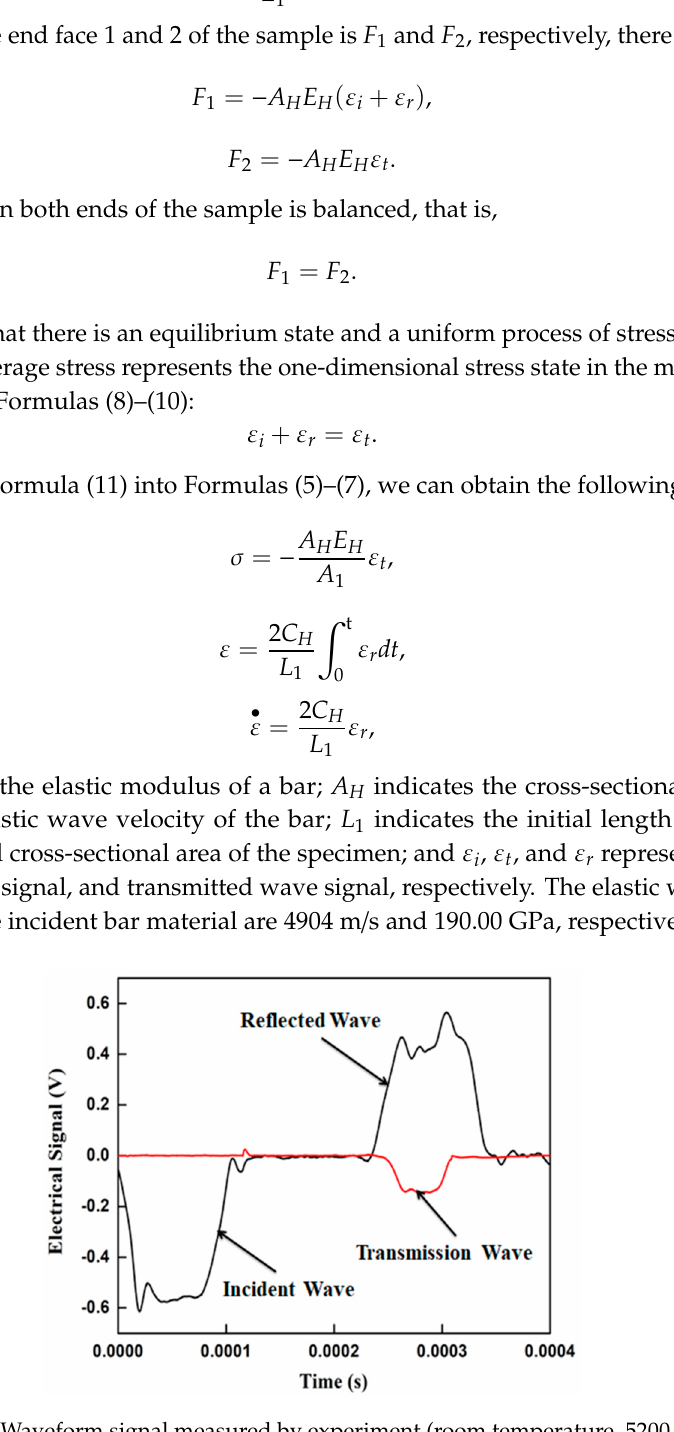
Figure 9. Waveform signal measured by experiment (room temperature, 5200 s − 1 ).